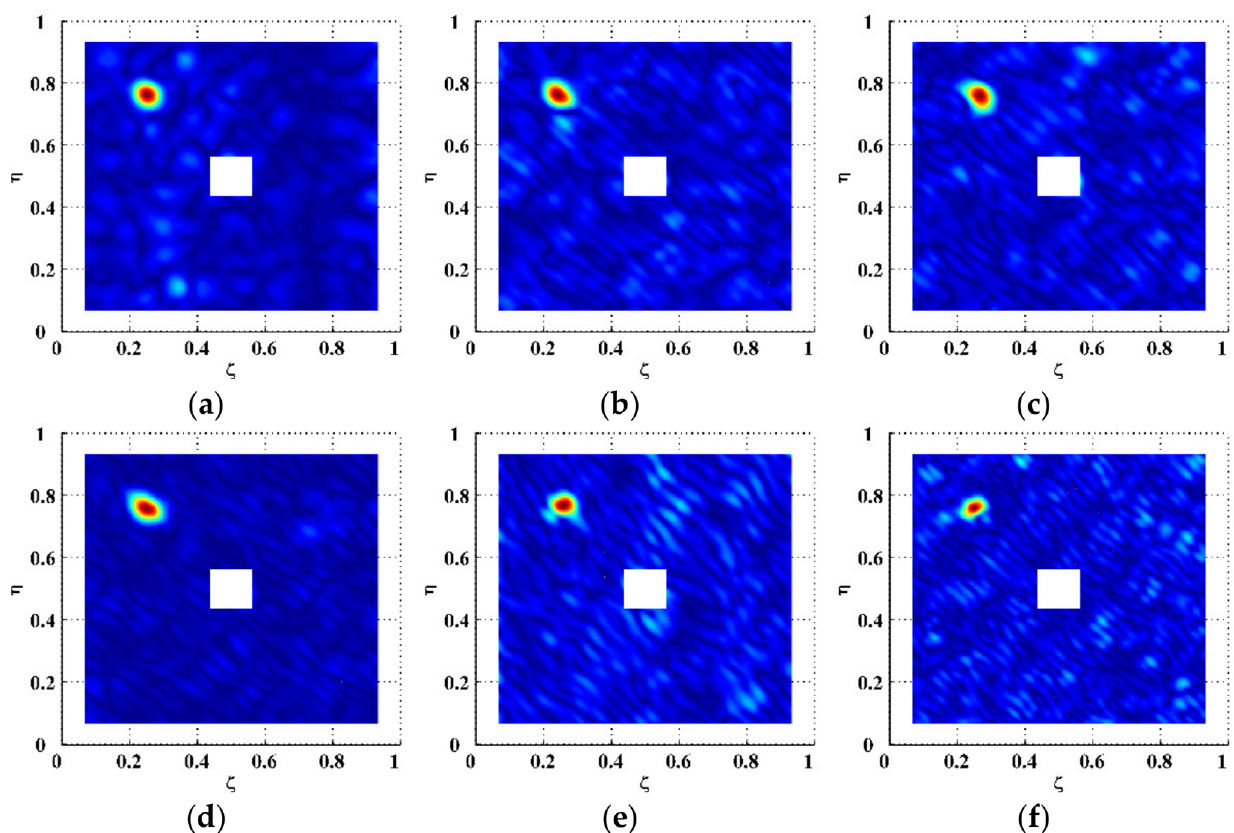
Figure 7. Wavenumber spectra of EMDIs for Scenarios ( a ) I, ( b ) II, ( c ) III, ( d ) IV, ( e ) V, and ( f ) VI.